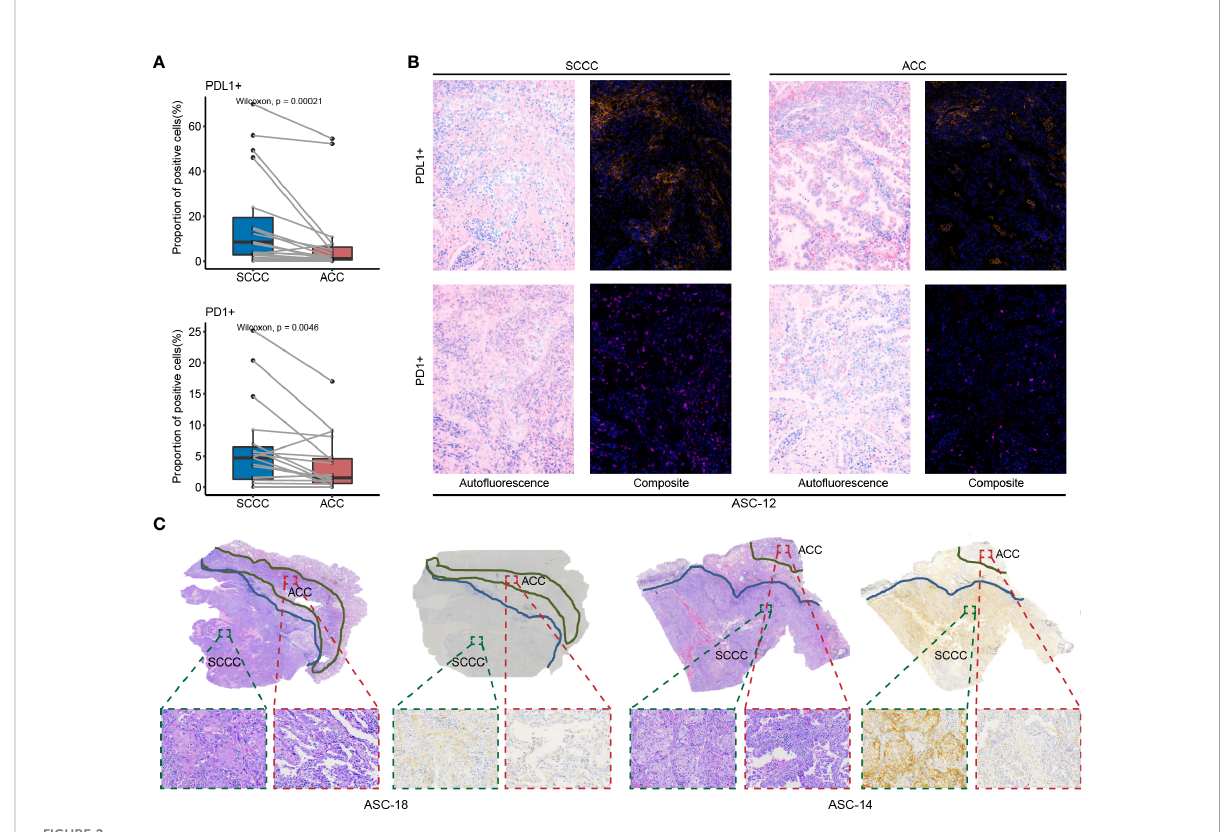
FIGURE 2 PD-L1 and PD-1 expression patterns in lung adenosquamous carcinoma (ASC). (A) PD-L1 and PD-1 expressions are assessed using multiple immuno fl uorescences. PD-L1 and PD-1 are strongly expressed in squamous cell carcinoma component (SCCCs) versus adenocarcinoma components (ACCs). (B) A case of classical ASC shows PD-L1 and PD-1 expressions in SCCCs and ACCs. (C) Two cases of classical ASC reveal PD-L1 and PD-1 expressions in SCCCs and ACCs. Dako PD-L1 immunohistochemistry shows the difference in PD-L1 expression between ACCs and